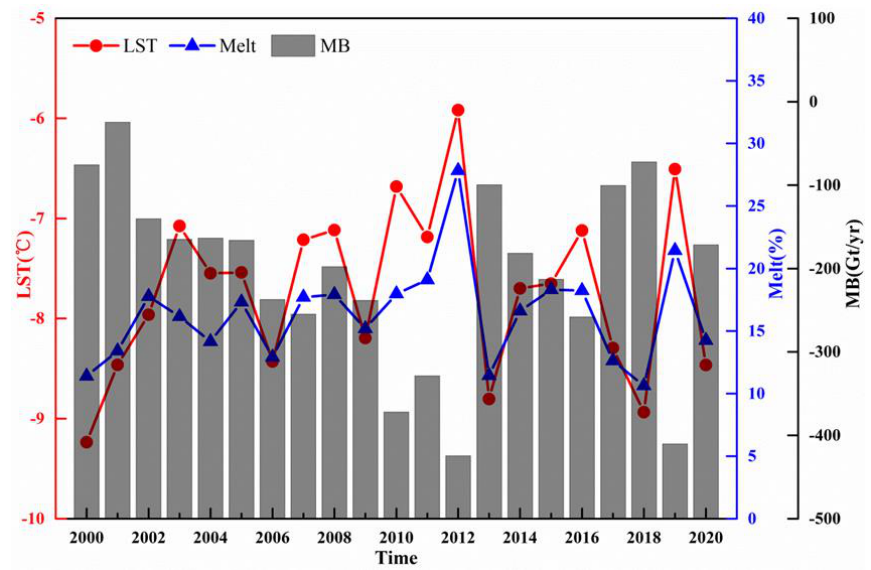
Figure 9. Time series of summer surface temperature, melting extent and mass balance of the GrIS.